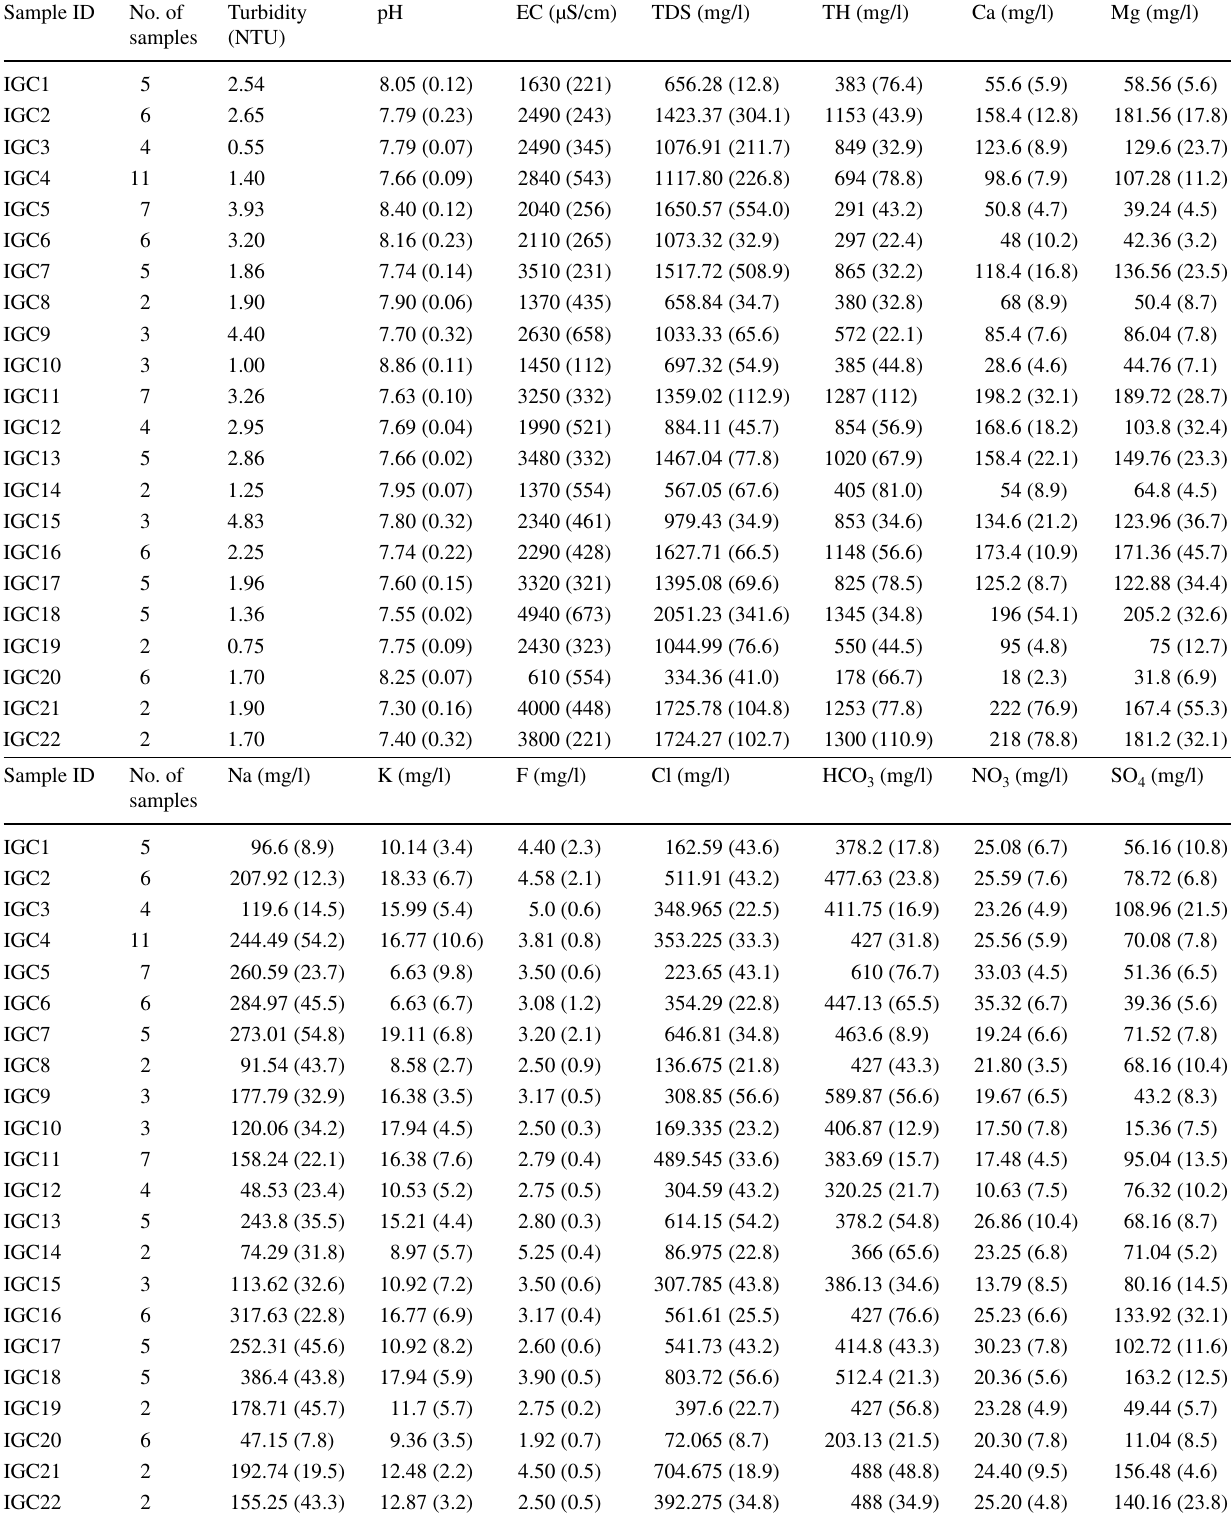
Table 1 Analytical results (mean values) of groundwater samples in Indira Gandhi Canal catchment area (site